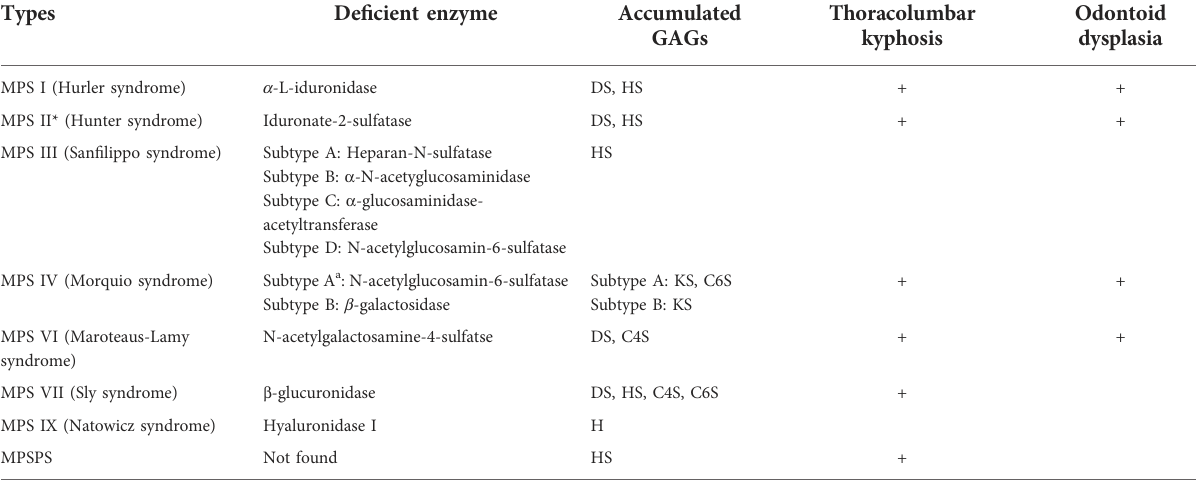
TABLE 1 Different types of